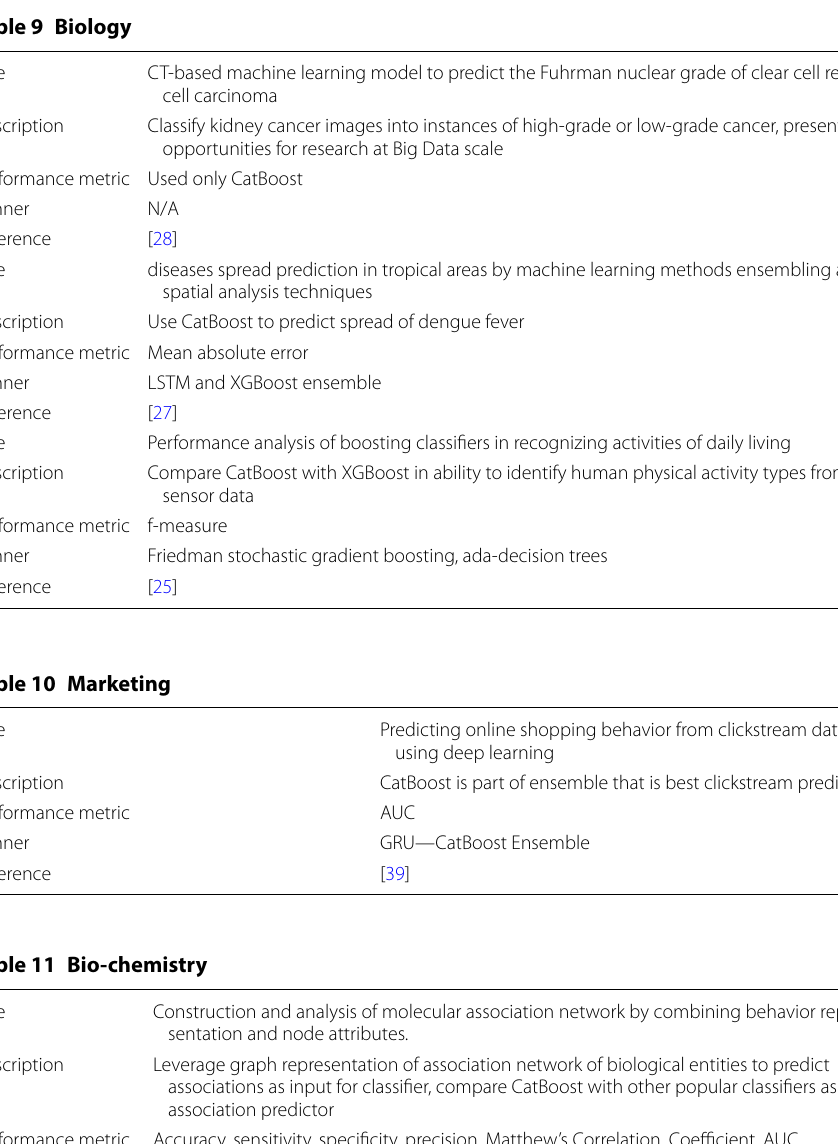
Construction and analysis of molecular association network by combining behavior repre- sentation and node attributes. Description Leverage graph representation of association network of biological entities to predict associations as input for classifier, compare CatBoost with other popular classifiers as association predictor Performance metric Accuracy, sensitivity, specificity, precision, Matthew’s Correlation, Coefficient, AUC, Winner CatBoost (except Sensitivity) Reference Prediction model of aryl hydrocarbon receptor activation by a novel QSAR approach, deepSnap–deep learning Description Compare CatBoost to other learners in image processing task related to study relationship between genes and liver function Performance metric AUC, accuracy Winner DeepSnap-DL (deep learning